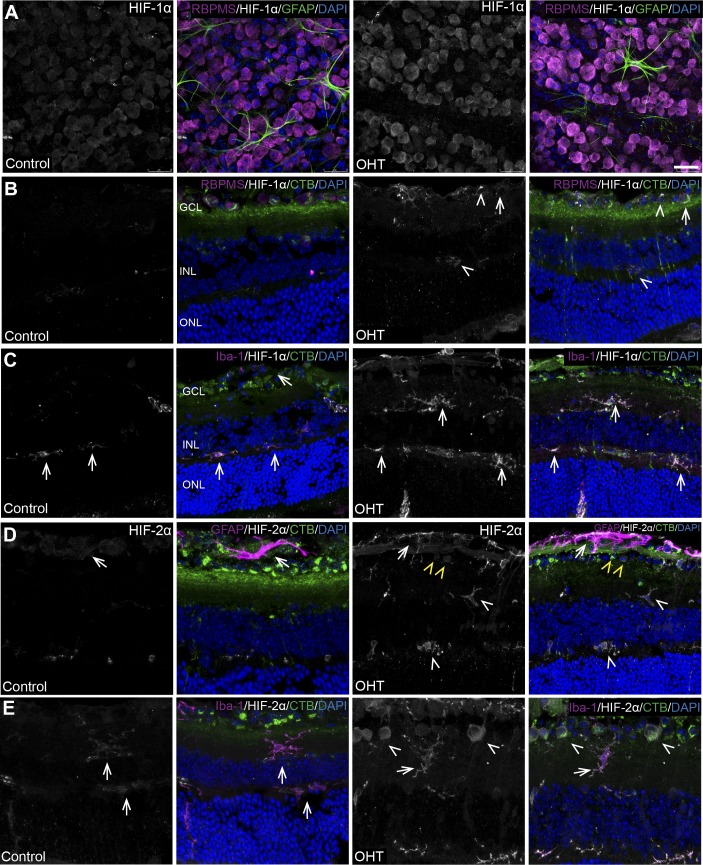
Significant increases of HIF-1α and HIF-2α, colocalized with GFAP and Iba-1 in retina after 4 weeks of OHT. (A) Whole-mount retina shows an increase in HIF-1α levels (white) with OHT compared with control. Colocalization of HIF-1α (white) with RBPMS (magenta) in RGCs. GFAP (green) and DAPI (blue). Ctrl: n = 4, OHT: n = 6. Scale bar: 25 μm. (B) Sagittal section of OHT retina shows an increase in HIF-1α level (white) compared with control. Colocalization of HIF-1α (white) with RBPMS (magenta) in RGCs (arrows) and in glia in the NFL and the INL (arrowheads). (C) Sagittal section of OHT retina shows an increase in HIF-1α level (white) compared with control. Colocalization of HIF-1α (white) with Iba-1 (magenta) in microglia (arrows) of retina. (D) Sagittal section of OHT retina shows an increase in HIF-2α level (white) compared with control. Colocalization of HIF-2α (white) with GFAP (magenta) in astrocytes in the NFL (arrows). HIF-2α localized to microglia in the inner and outer plexiform layers (white arrowheads) and in GCL neurons (yellow arrowheads). (E) Sagittal section of OHT retina shows an increase in HIF-2α level (white) compared with control. Colocalization of HIF-2α (white) with Iba-1 (magenta) in microglia (arrows). HIF-2α is also localized to RGCs in the GCL. CTB (green) and DAPI (blue). n = 3 independent control retinas and 3 independent OHT retinas. Scale bar: 25 μm.